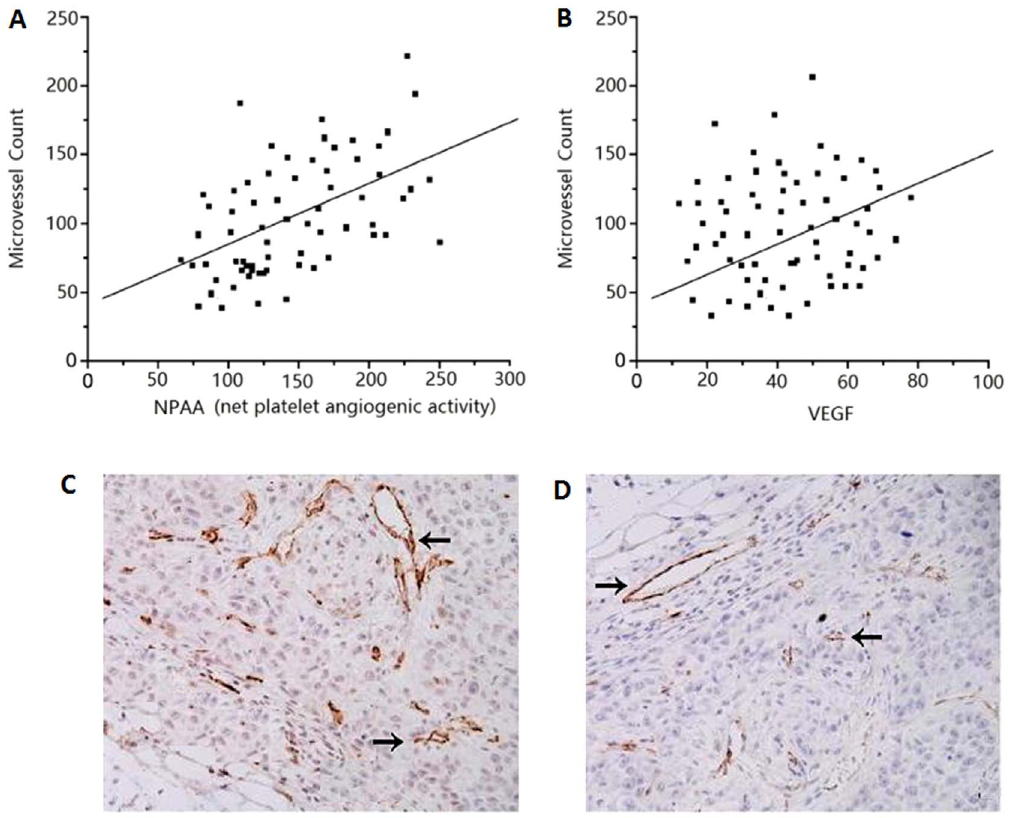
Figure 3. Correlation between tumor MVD and NPAA or platelet-derived VEGF levels. (A) Good correlation between MVD and NPAA in 68 NSCLC patients (r=0.78; P , 0.001). (B) The significant correlation between tumor MVD and platelet-derived VEGF levels (r=0.521; P , 0.01). (C) MVD in NSCLC tissue and (D) normal tissue were determined by CD34 immunohistochemical staining. Arrow, positive stain of MVD.